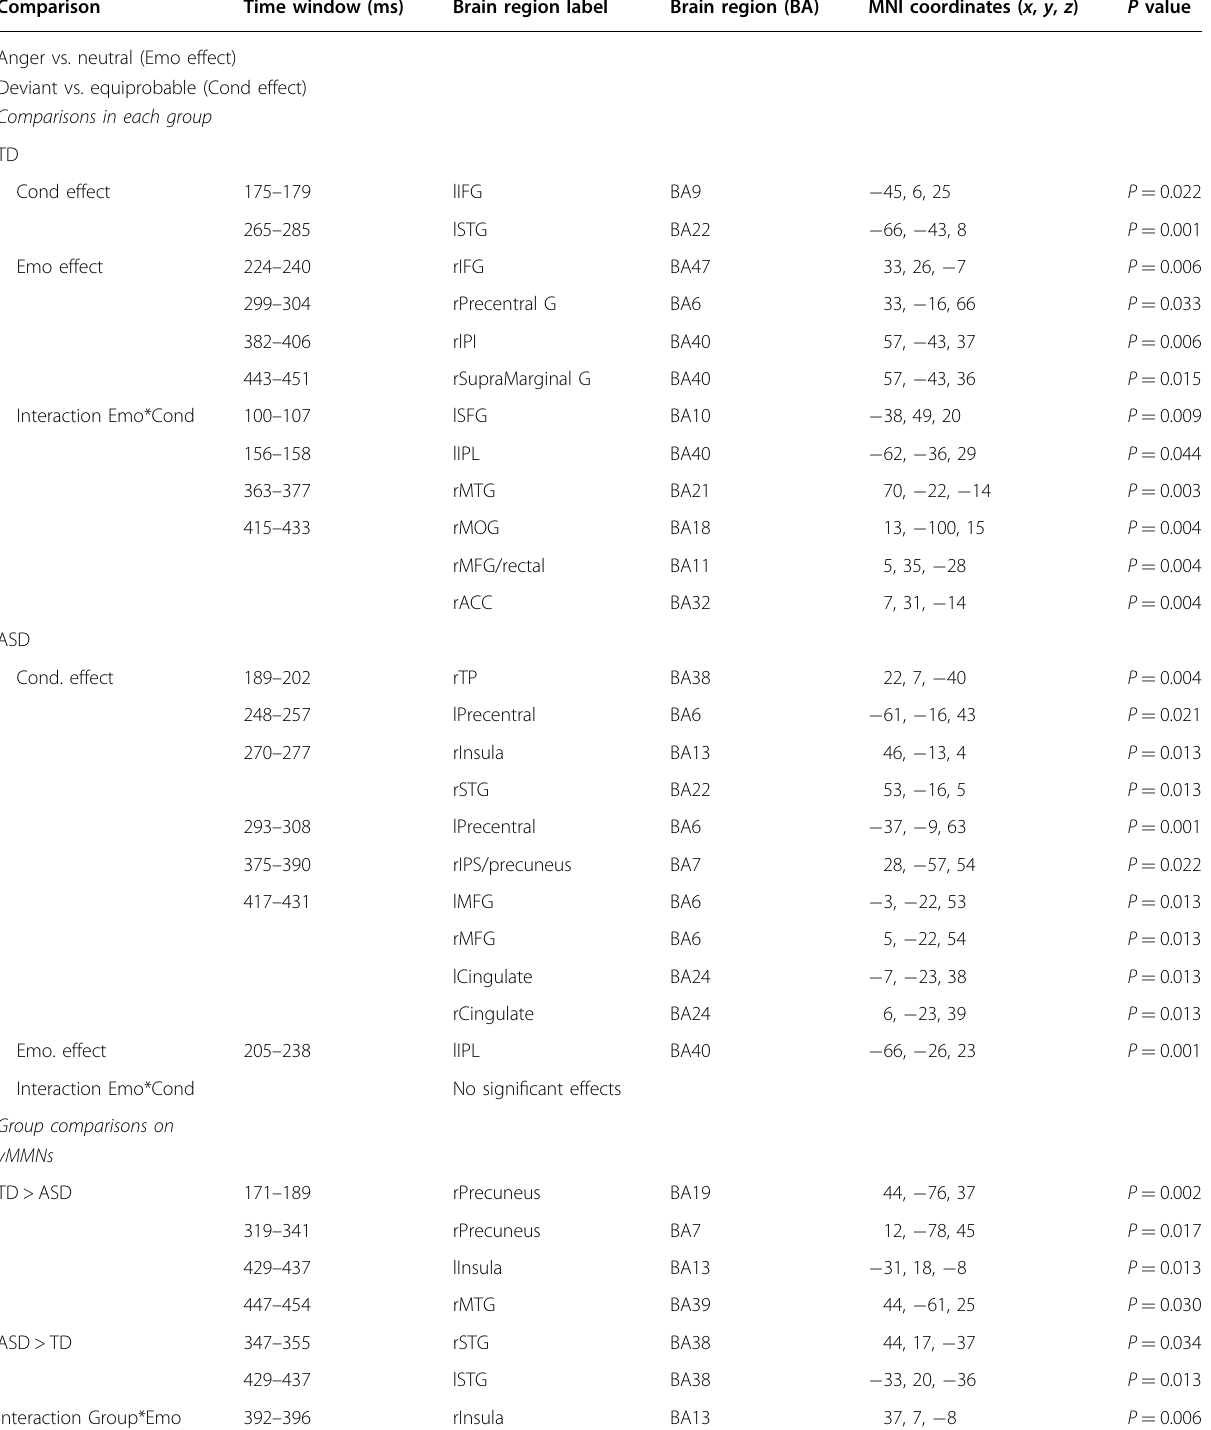
Table 1 CDR statistical